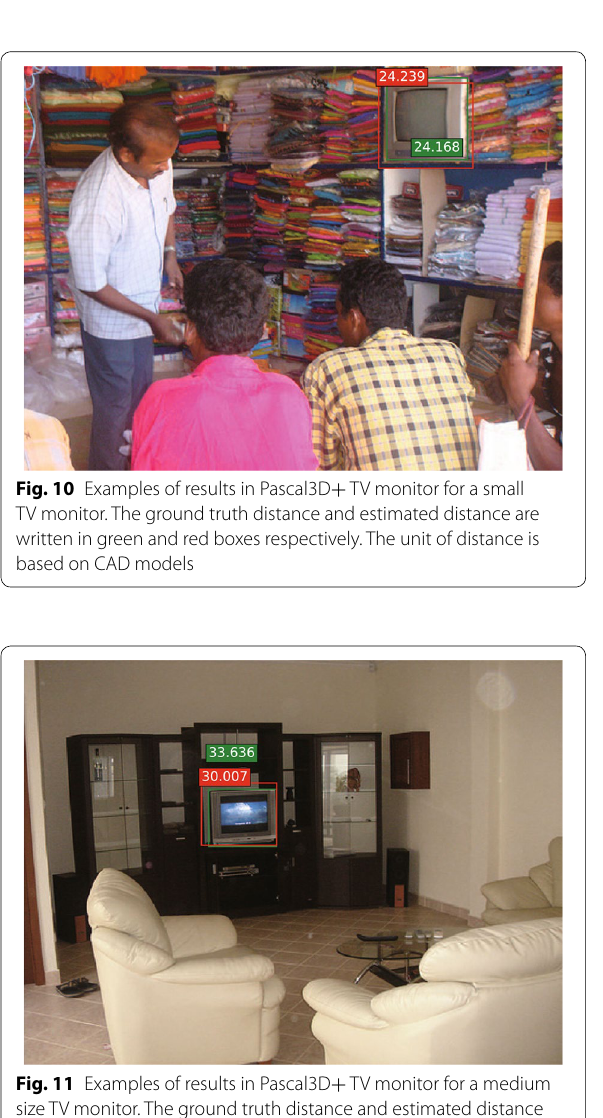
TV monitor for a medium +